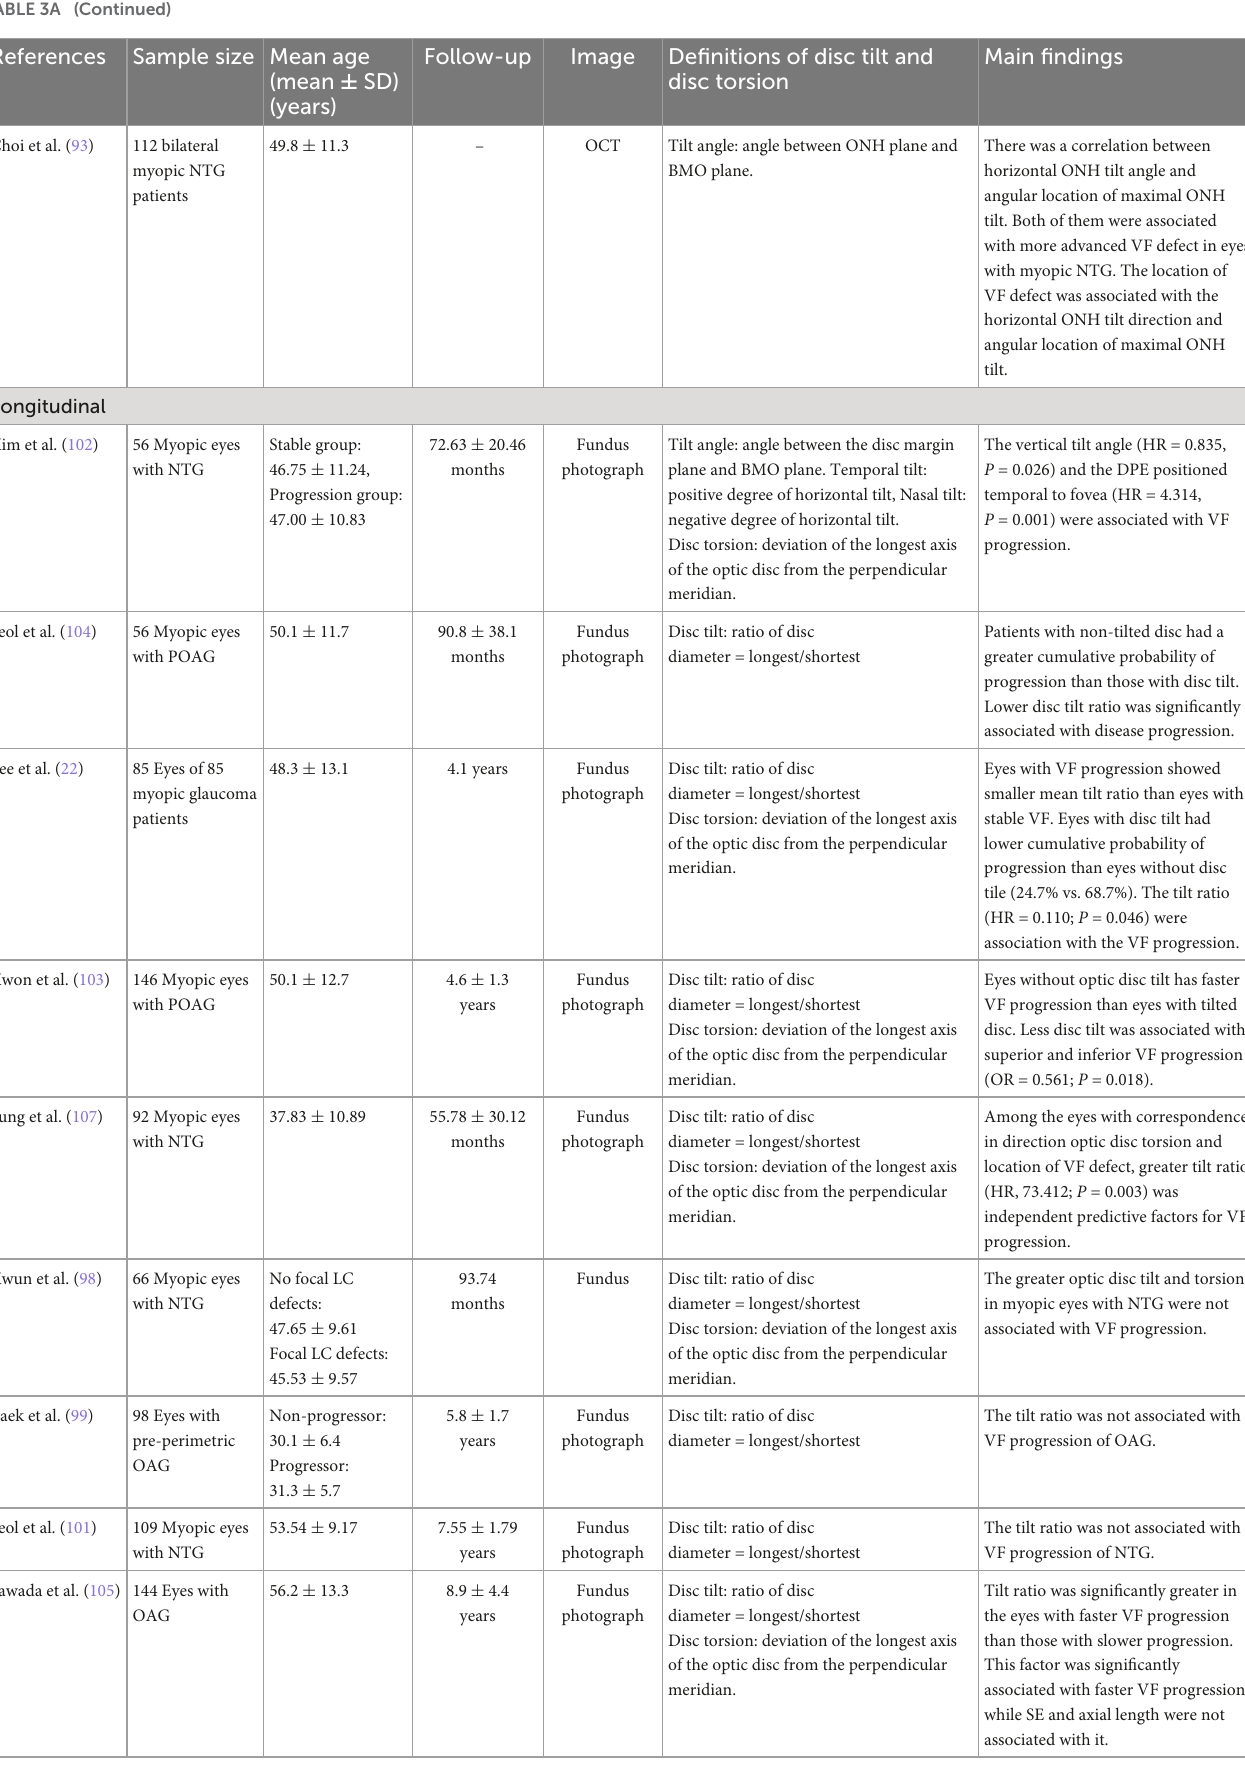
Fundus Disc tilt: ratio of disc photograph diameter = longest/shortest Disc torsion: deviation of the longest axis of the optic disc from the perpendicular